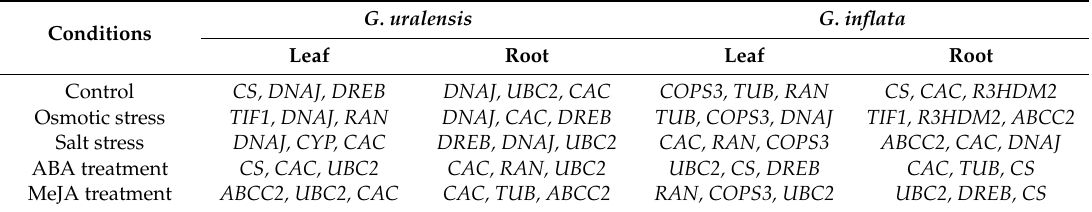
Table 1. The top three recommended reference genes under di ff erent experimental conditions in G. uralensis and G. inflata